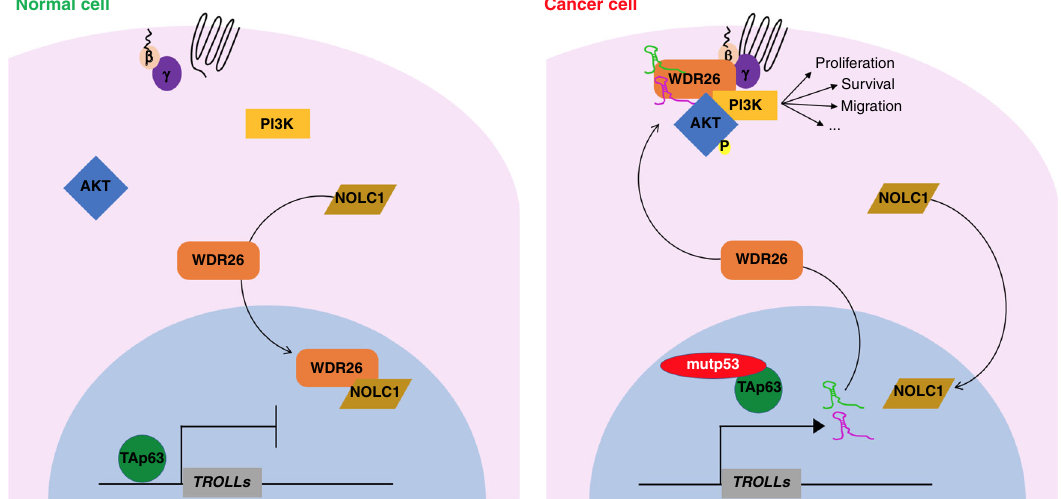
Fig. 7 Model. Scheme describing the proposed mechanism of action of TROLL-2 and TROLL-3 . In normal cells (e.g. MCF10A cells) the tumour and metastasis suppressor TAp63 inhibits the expression of TROLL-2 and TROLL-3 , while NOLC1 interacts with WDR26 and promotes the accumulation of WDR26 in the nucleus. In cancer cells (e.g. CA1D cells), instead, mutant p53 inhibits TAp63, thus allowing for the expression of TROLL-2 and TROLL-3 . These lncRNAs counteract the interaction between NOLC1 and WDR26, while promoting the binding of WDR26 to AKT. As a consequence, the PI3K/AKT pathway is activated and can sustain tumour formation and